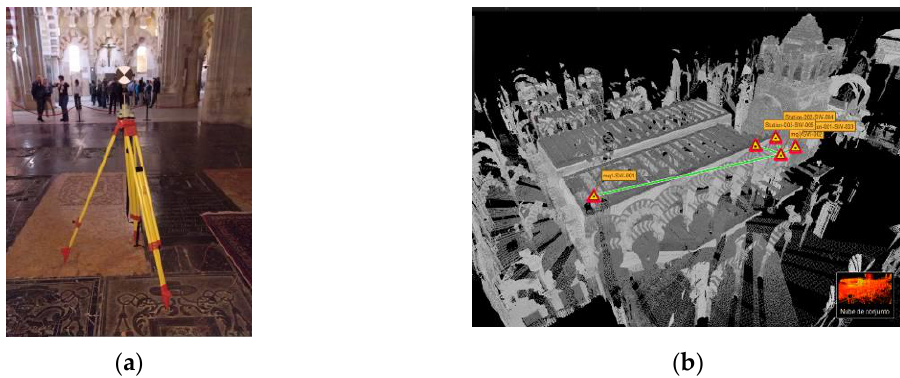
Figure 14. ( a ) Target used to give coordinates and get orientation ( b ) links between scan stations. Source: Own images.